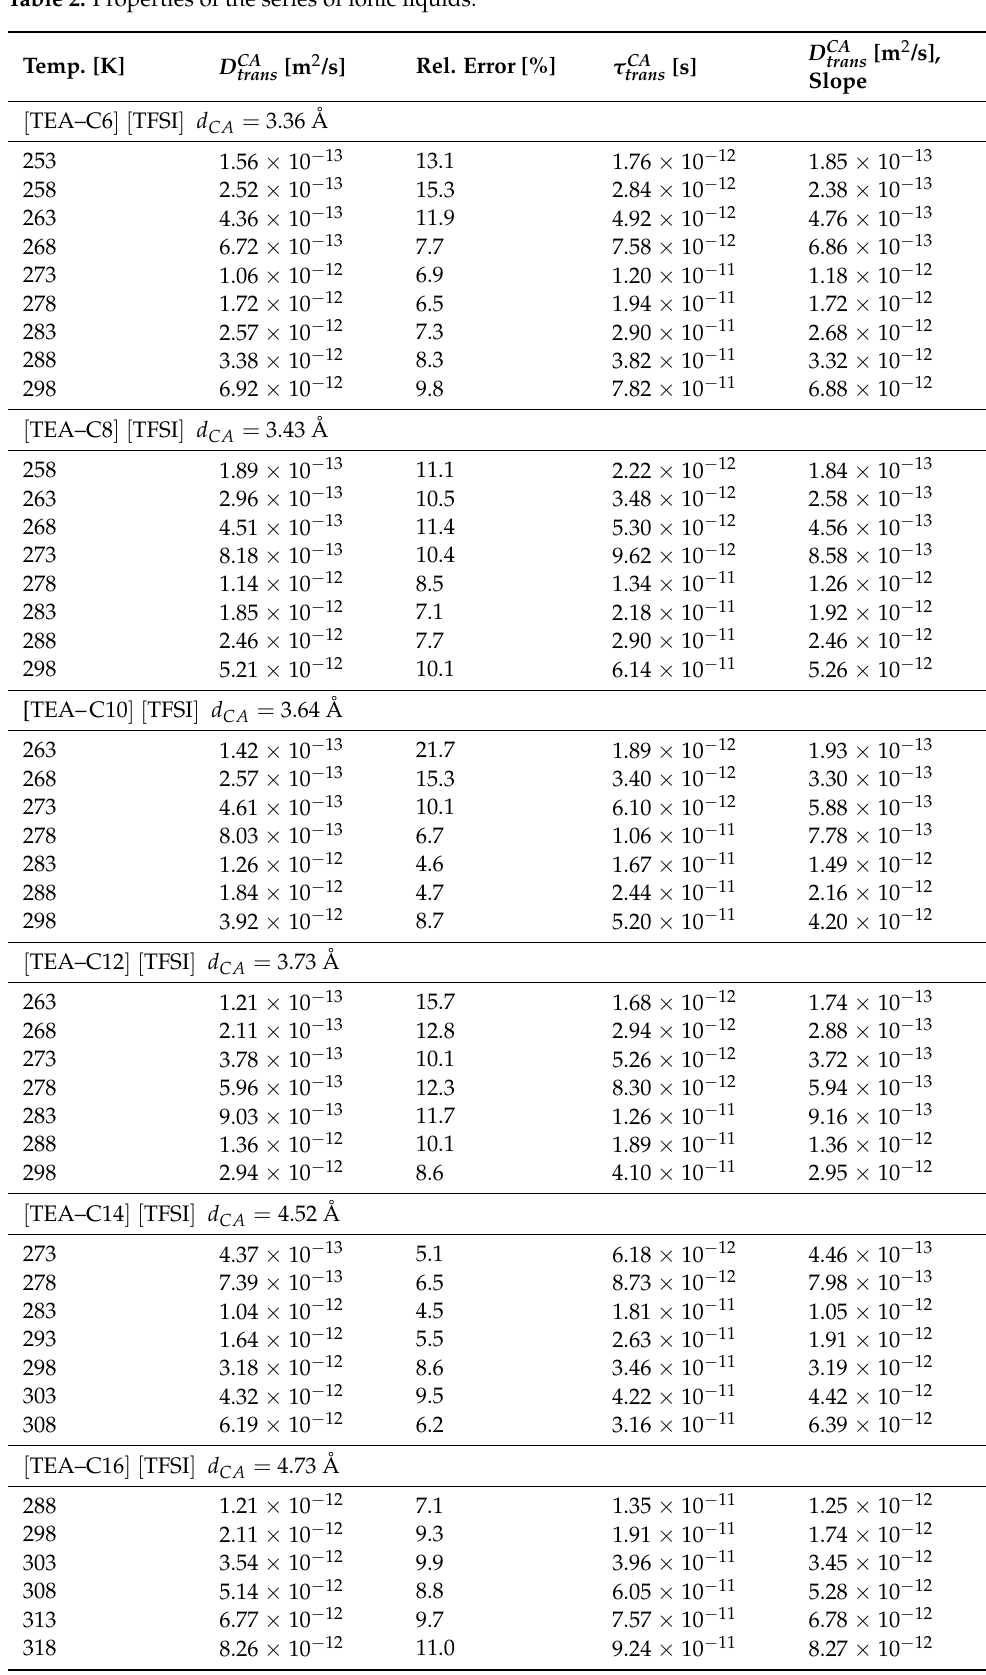
Table 2. Properties of the series of ionic